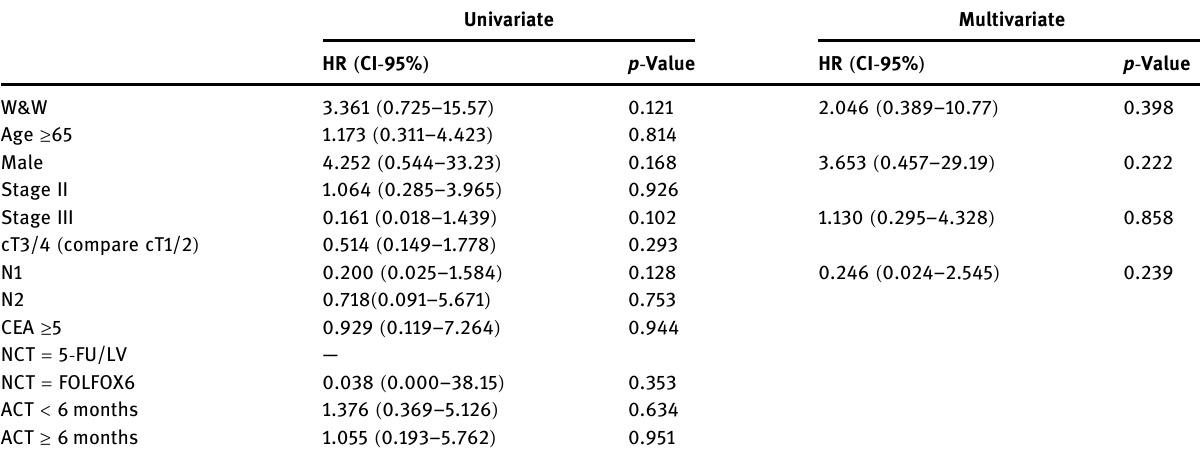
Table 3: Cox regression analysis of risk factors for recurrence